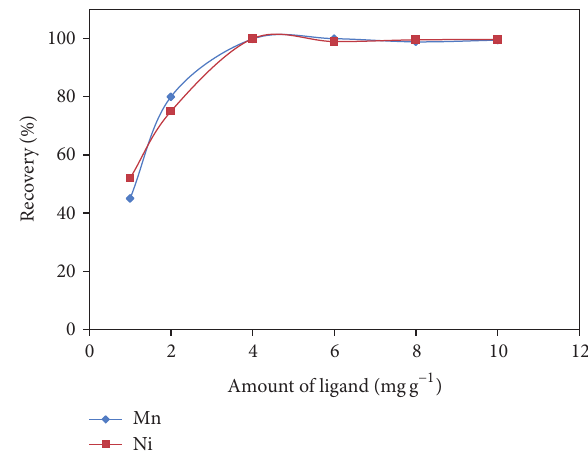
F 3: Effect of amount of diimine derivative Schiff base (ligand) on the recovery of Ni (II) and Mn (II) on column. Concentration